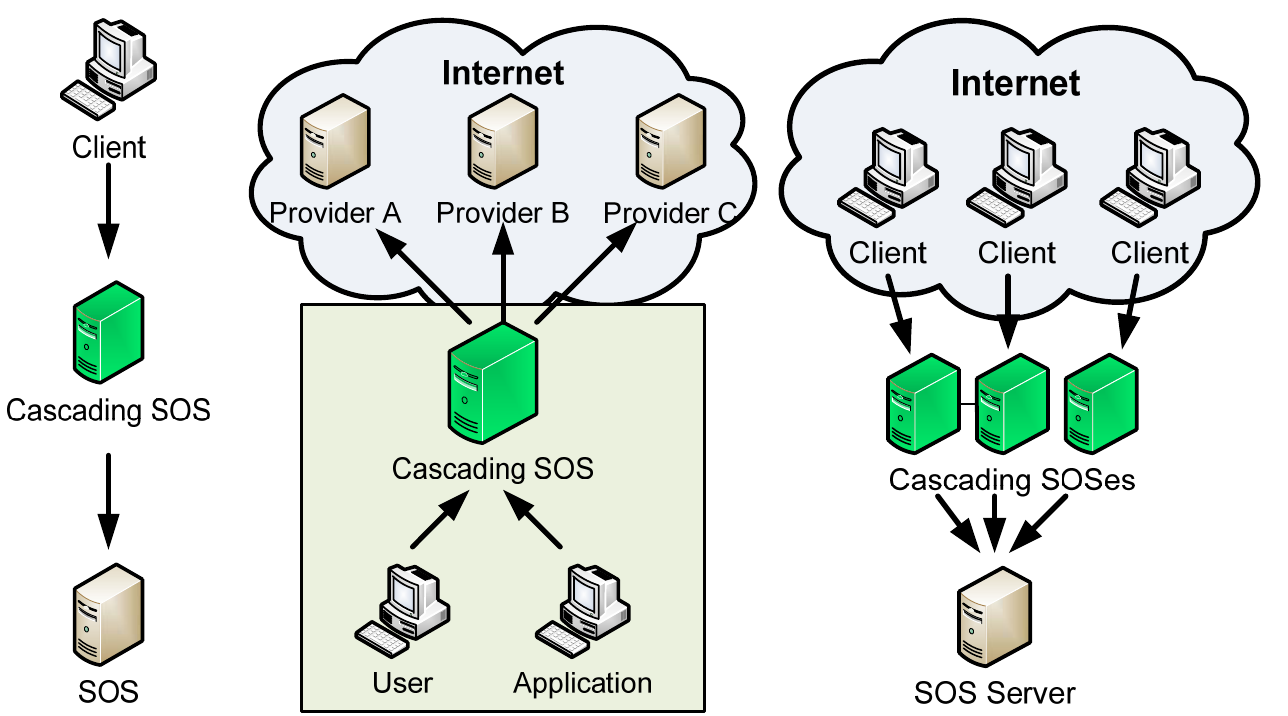
Figure 3. From left to right: (a) UC3 “Protocol Transducer”; (b) UC4 “SOS Proxy”; (c) UC5 “Load